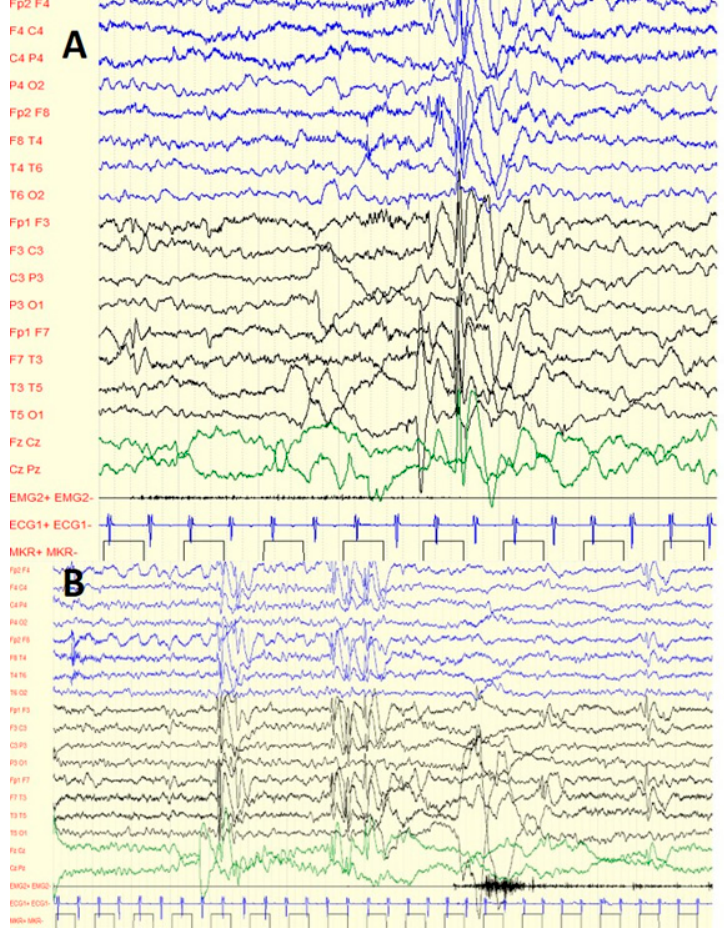
Figure 1. Six-year-old boy with C1M and GTC: ( A ) interictal diffuse spike waves during sleep; ( B ) interictal focal spike waves (fronto-central regions) during sleep.